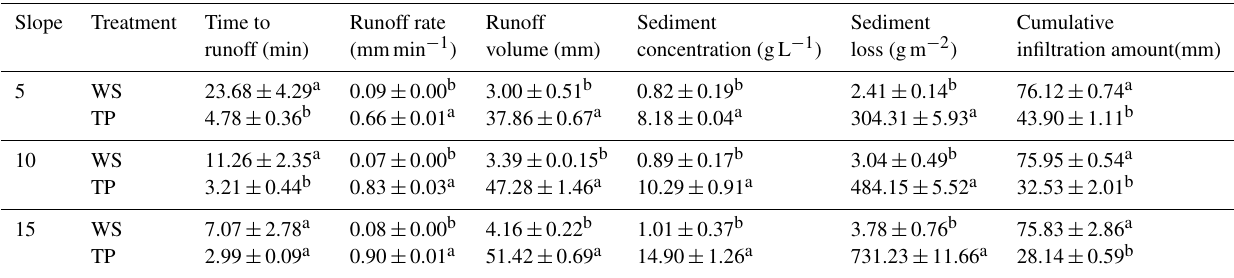
Table 2. The time to runoff initiation, runoff rate, runoff volume, sediment concentration and loss, and cumulative infiltration amount for WS and TP under each